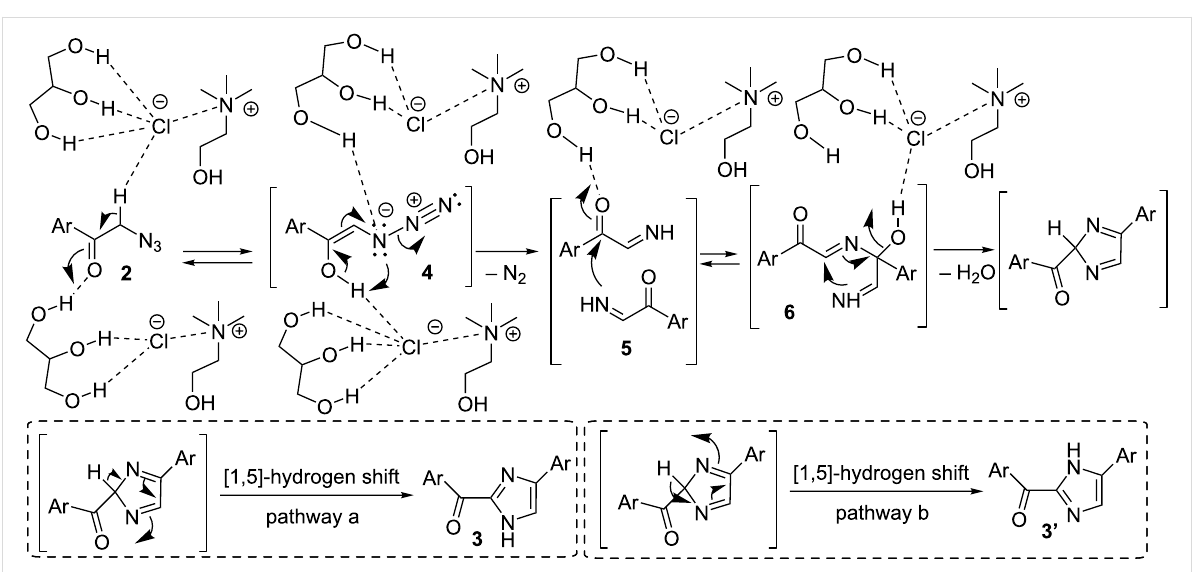
Scheme 4: Proposed mechanism for the formation of 2-aroyl-(4 or 5)-aryl-(1 H )-imidazoles 3 / 3' from α -phenacyl azides 2 in